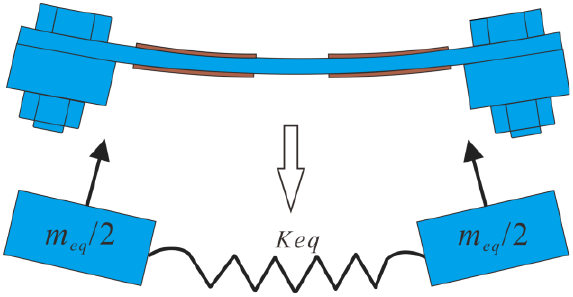
Figure 5. Equivalent model of the resonator with mass blocks.